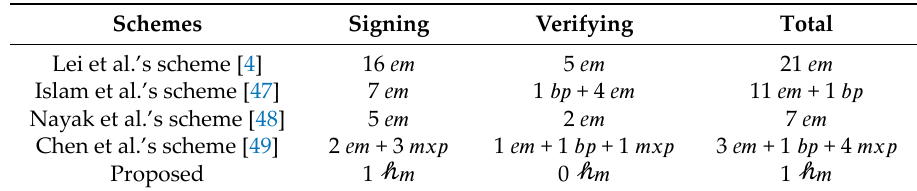
Table 2. Computational cost.